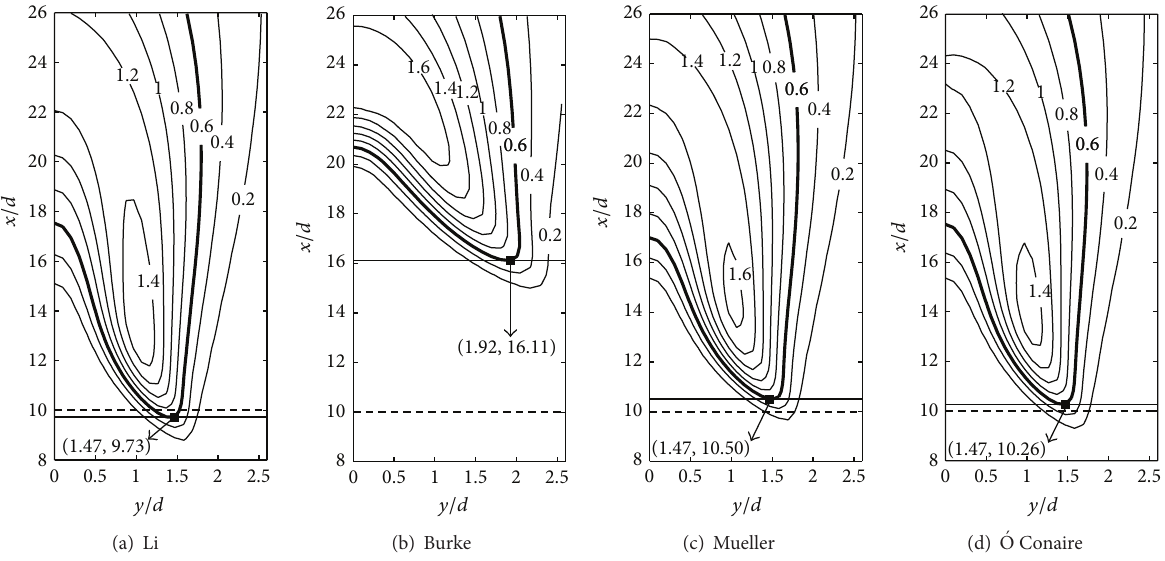
̃𝑌 (×10 3 ) obtained using the mechanisms of (a) Li et al. [41], (b) Burke et al. [42], (c) Mueller et al. [40], and (d) Figure 15: Contours of OH ´O Conaire et al. [43]. The thick contours correspond to 600ppm. The solid and dashed horizontal lines correspond to the numerical and experimental liftoff heights, respectively. The CSDR is modelled using Girimaji’s model and 𝑇 𝑐 = 1045 K.